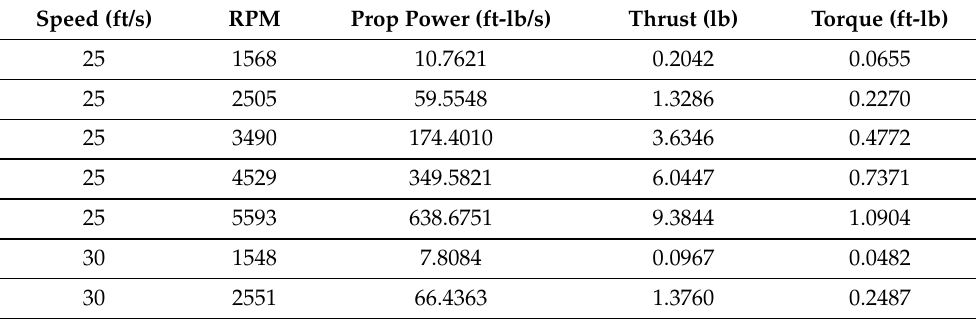
Table A14. APC 18 × 14 propeller wind tunnel raw